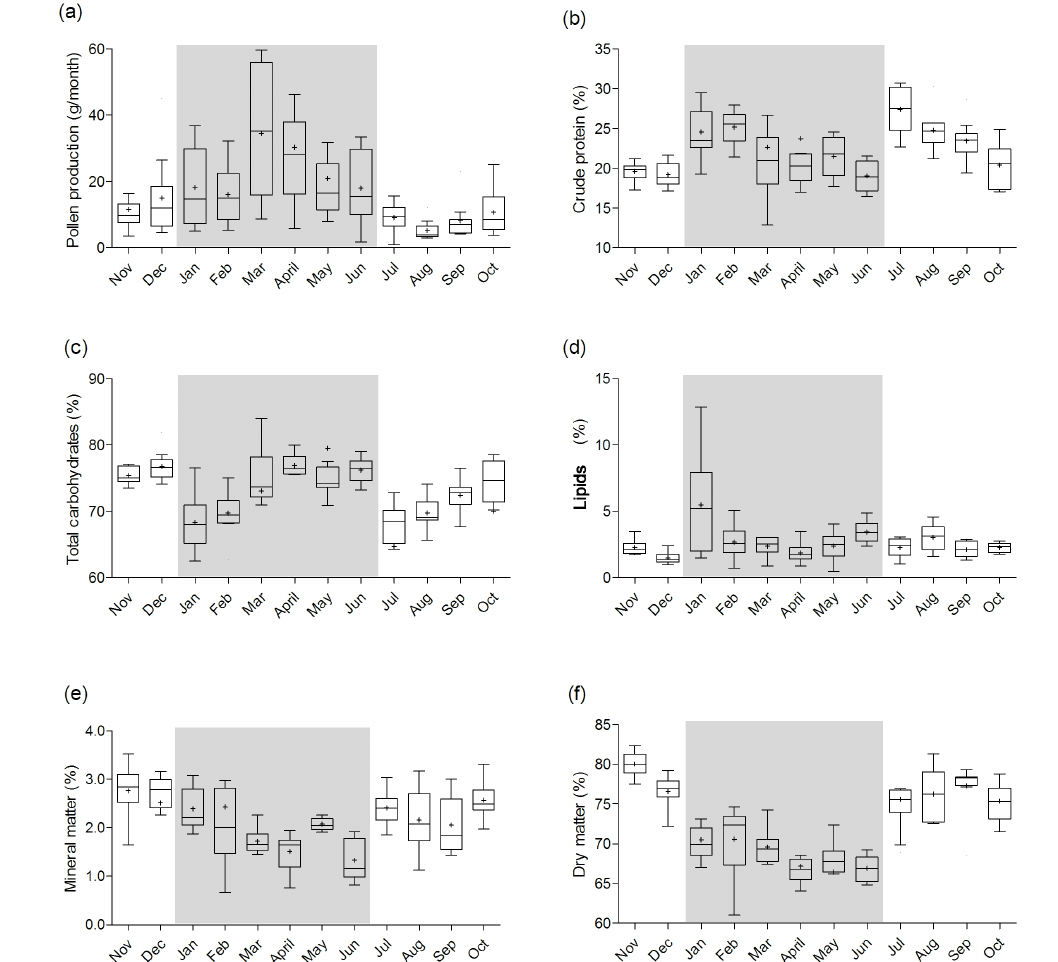
Fig 3 . Temporal variation in production of bee pollen used in the diet of Apis mellifera and its nutritional value. ( a ) Annual production of bee pollen. ( b ) Total protein. ( c )Total carbohydrate. ( d ) Lipids. ( e ) Mineral matter. ( f ) Dry matter. The symbol + represents the mean of each month. Months highlighted in gray correspond to the rainy season and months highlighted in white represent the dry